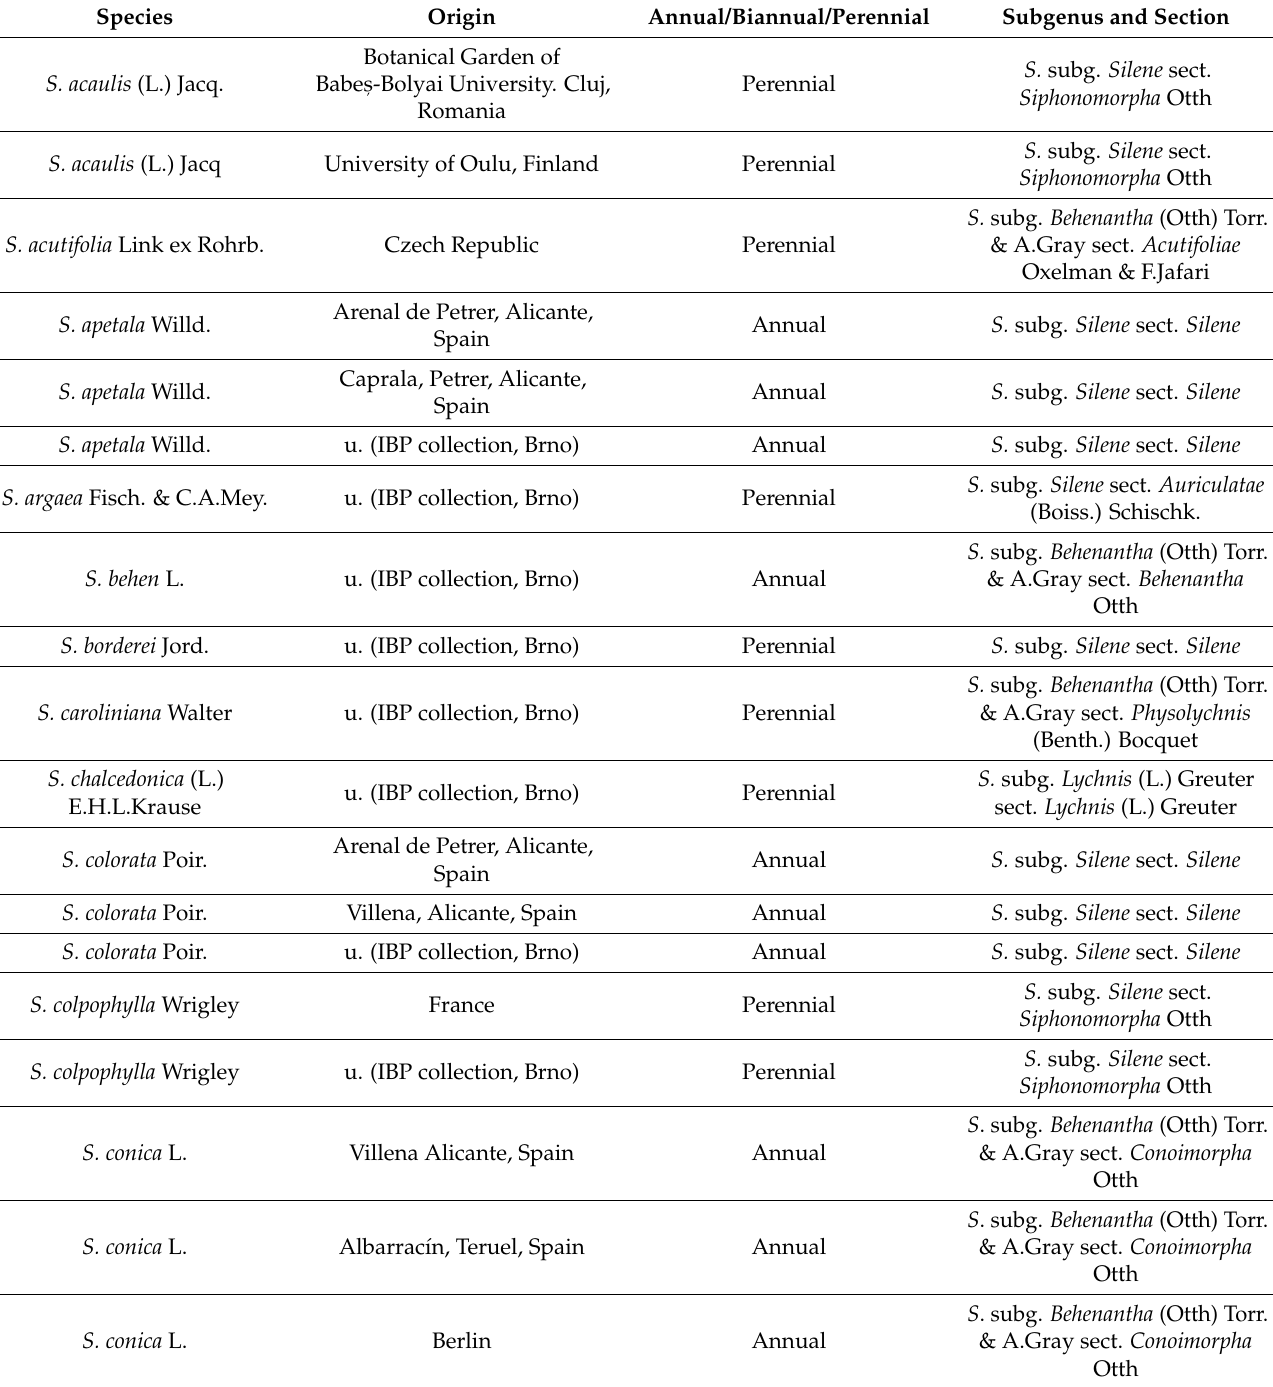
Table A1. A total of 52 species and 104 populations belonging to Silene , Atocion and Viscaria are listed with an indication of the origin of the samples. The life span (annual, biannual and perennial plants) is indicated for each species according to Talavera [36], Morton [37], Chater and Walters [38], Davis et al. [39] and Danin and Fragman [40]. The taxonomical assignment of each species to subgenera and sections is taken from [3,41]. In the column, origin u. means